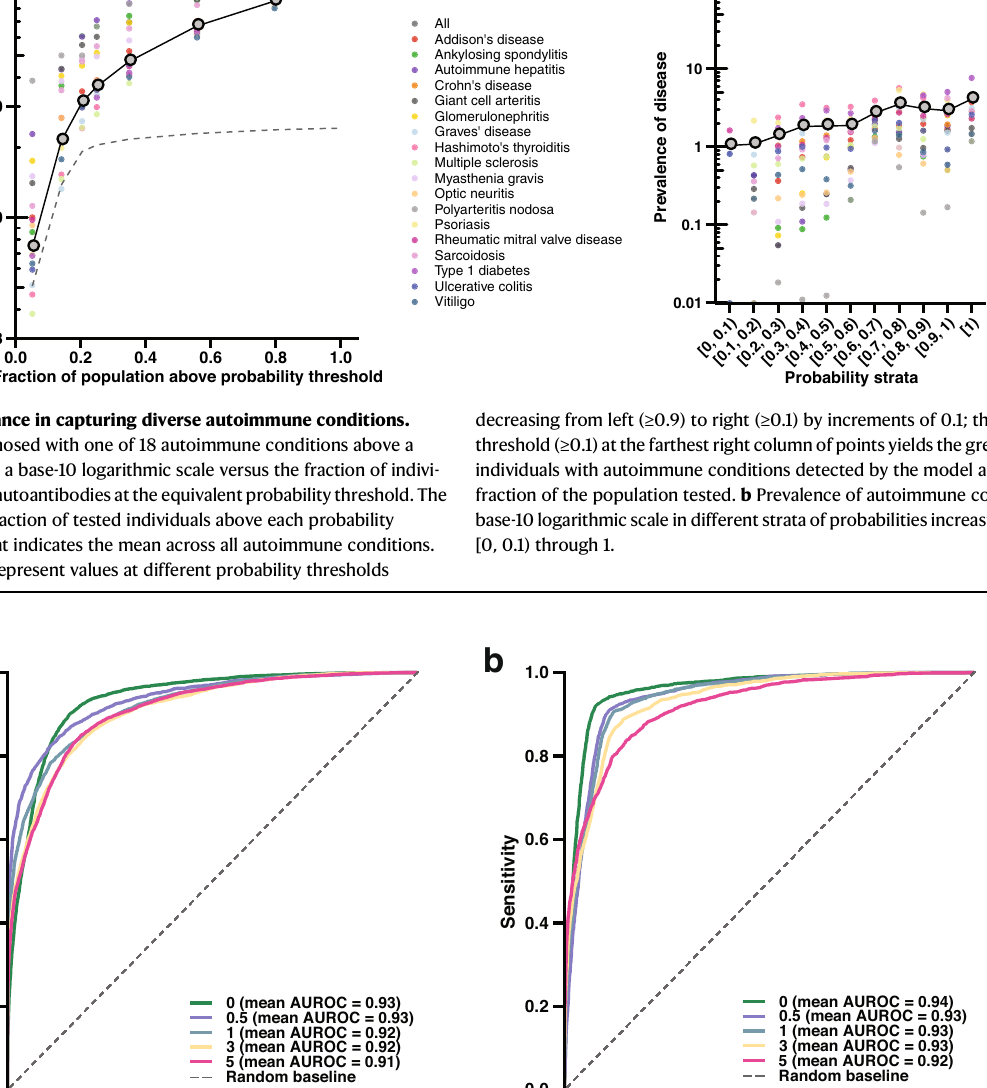
EHRdatawererestrictedto0,0.5,1,3,and5yearspriortothetestingorencounter dateforparticipantswhohadautoantibodytestingorarheumatologistencounter,